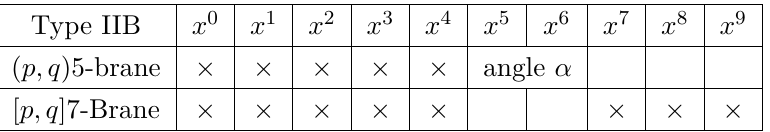
Table 1 . Occupation of space-time directions of the ( p, q ) 5-branes and [ p, q ] 7-branes in Type IIB are denoted by × . The angle α depends on the ( p, q ) charges and the axio-dilaton τ ; α = arg( p + τq ) . We set τ = i in the rest of the paper, s.t. tan( α ) = q/p . Our 5d N = 1 theories exist as effective field theories living on 5-branes suspended between